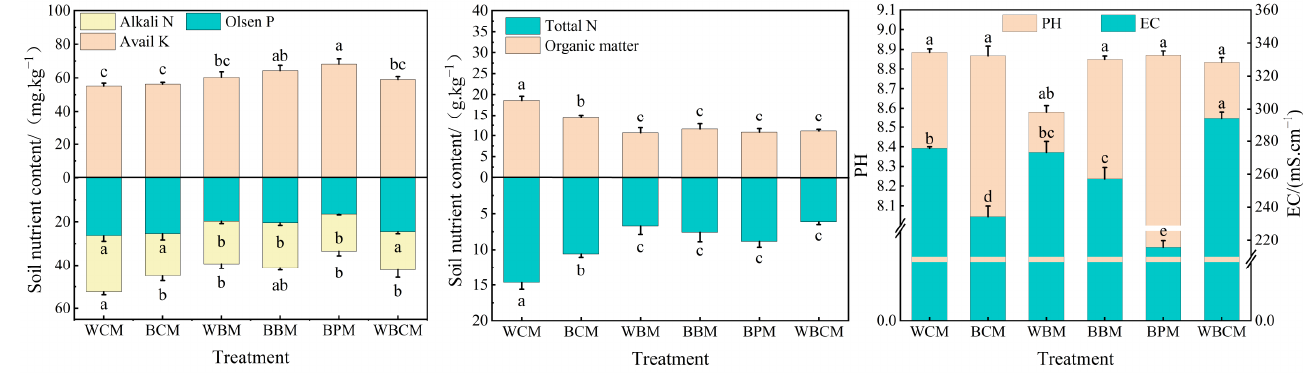
Figure 5. Effects of different treatments on soil physicochemical properties. Error bars represent ± SD. Values followed by the same letter within a column in each year are not significantly different at p ≤ 0.05, as determined by the HSD test.